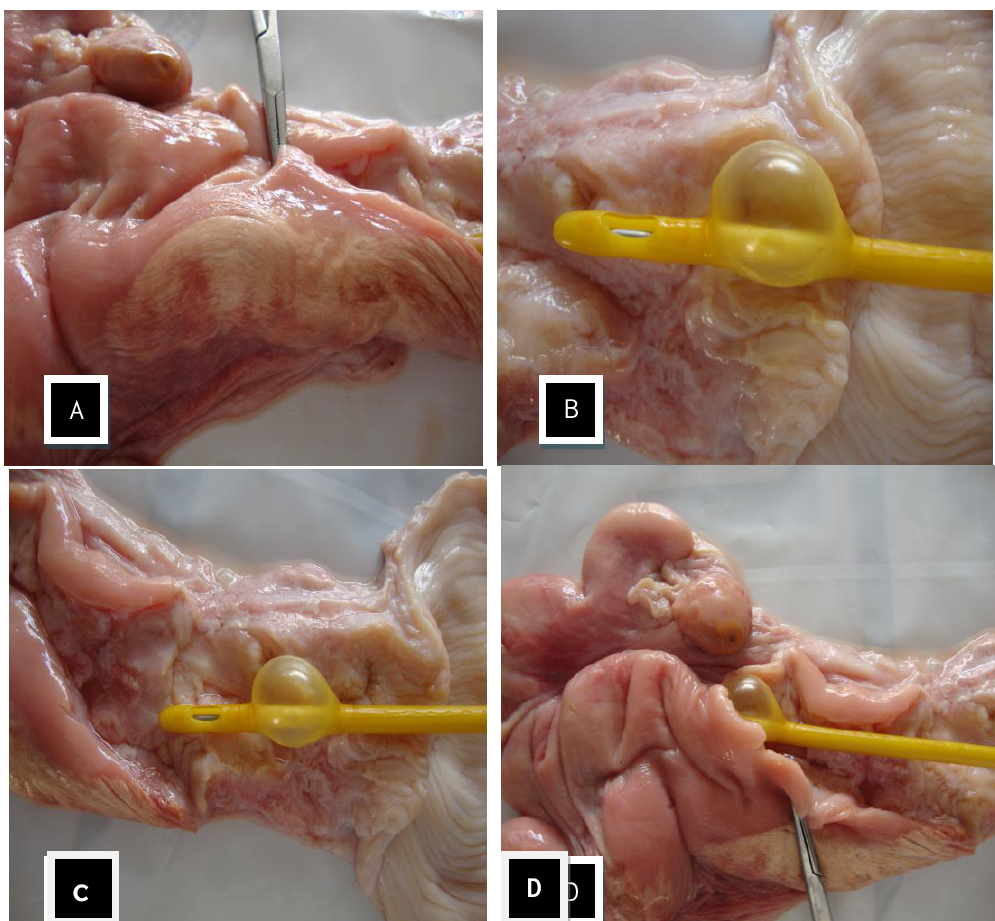
Figure 1: Show normal cow genetalia: before the introduction of the Foley catheter in the cervix (A), after introduction of Foley catheter in the first third (B), at the middle (C) or at the last third of the cervical canal